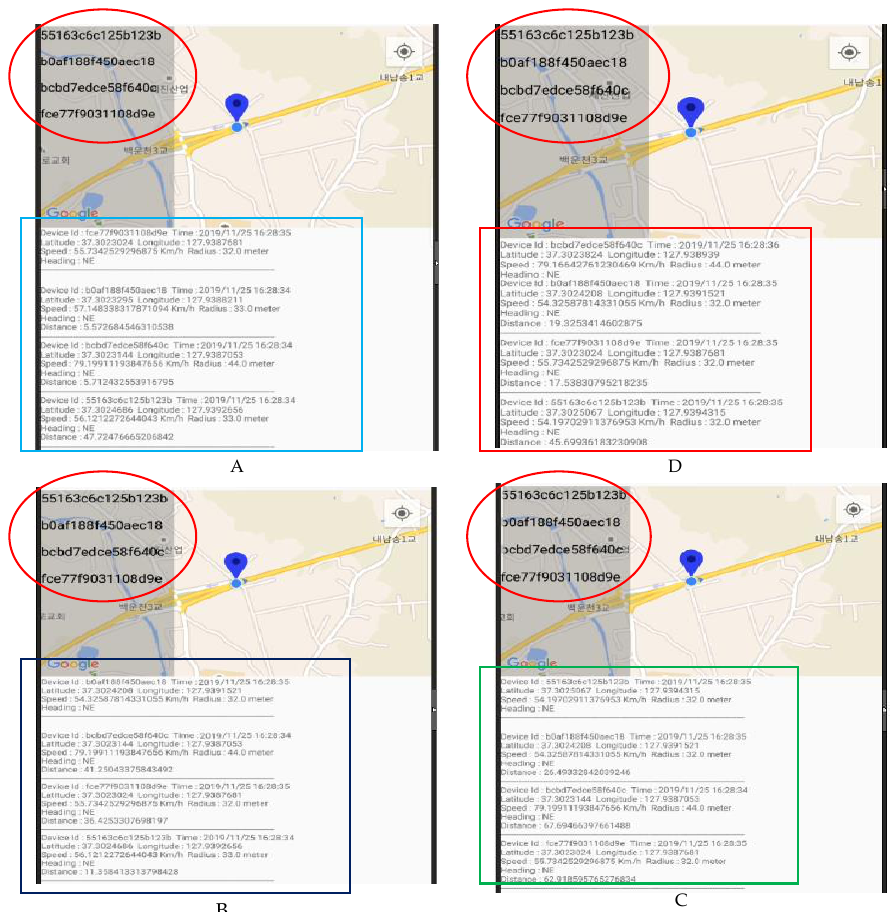
Figure 11. Screen images showing the formation of a fully connected group and the sequence of all vehicles.